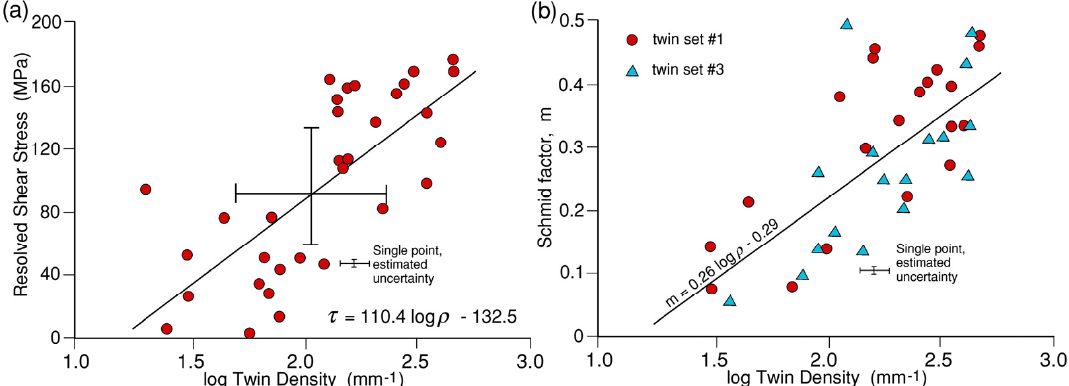
Figure 12. ( a ) Relationship between log twin density ( ρ ) and resolved shear stress ( τ ) along the twinning vector direction (twin sets #1 and #2) in 32 grains centred on the mean grain size (99 µ m).; ( b ) Schmid factor for twins in two twin sets (#1 and #3) plotted versus log twin density in 37 grains centred on the mean grain size, and for differential stresses in the range 360 to 372 MPa. Taking twin density as a proxy for shear strain if twin thicknesses are constant, shear strain increases with Schmid factor at constant stress and grain size.